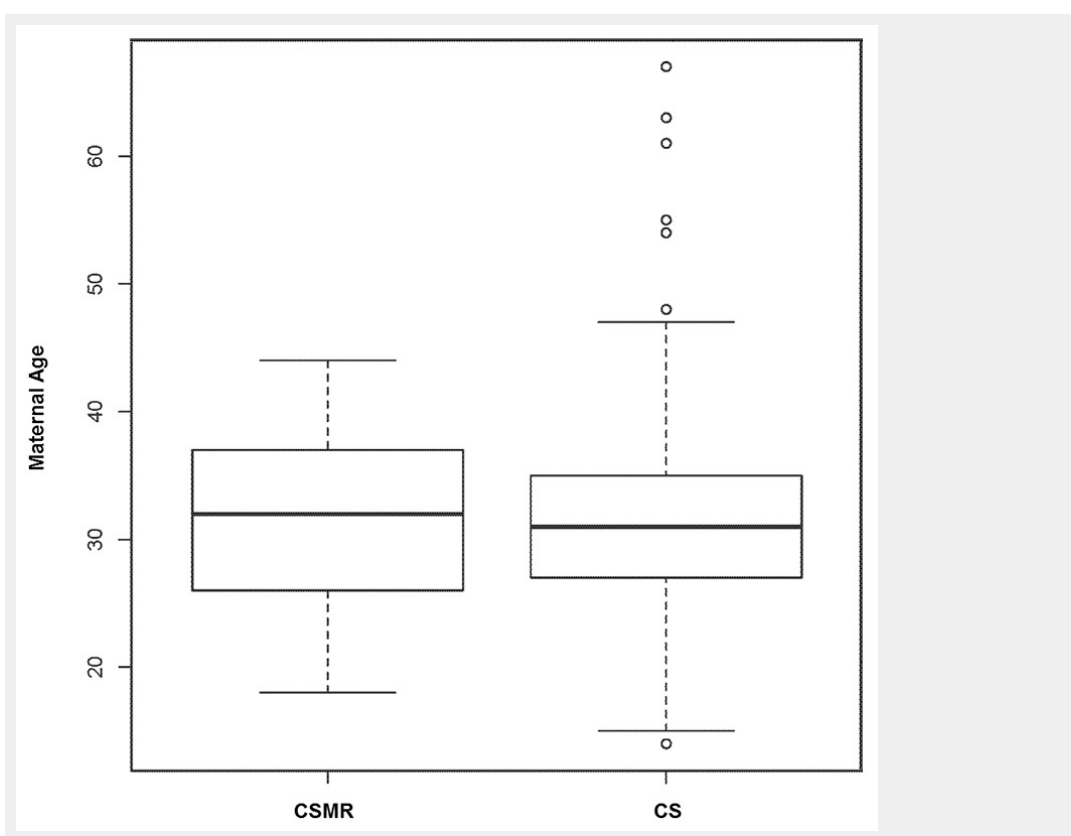
Figure 7 Comparison of maternal age in mothers with caesarean section on maternal request (CSMR) and all mothers with caesarean section (CS) was not significant (p =